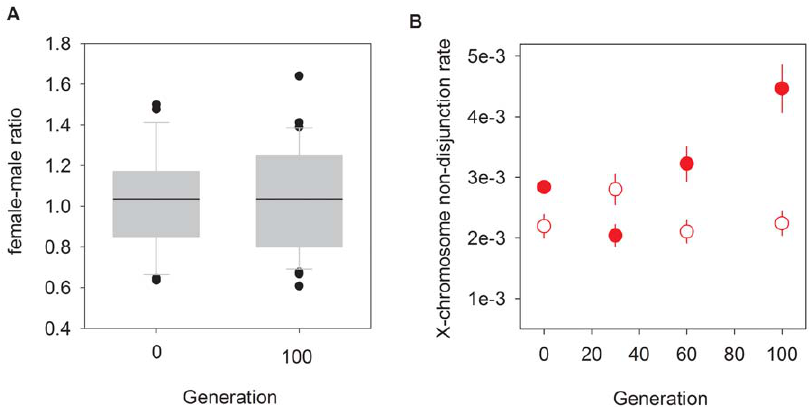
Figure 5. Evolution of sex ratio distorters. A shows the offspring sex ratio of individual dioecious males for the G0 population (n=27) and three G100 replicate populations (total n=37). Box-plots of the data at 10, 25, 75, and 90 percentiles are represented, along with outliers (dots), and the mean of each generation (line). In B , the evolution of X-chromosome non-disjunction rates in androdioecious populations is shown. The proportion of males in the grand-progeny of 50 selfing hermaphrodites was scored in populations with (filled circles) or without (empty circles) starting diversity. Symbols indicate the average number of males per replicate population and mating system with SEM. GLM analysis reveals that generation is significant (p=0.01) as well as block, initial diversity condition, and interaction (all at p , 0.001; total residual deviance